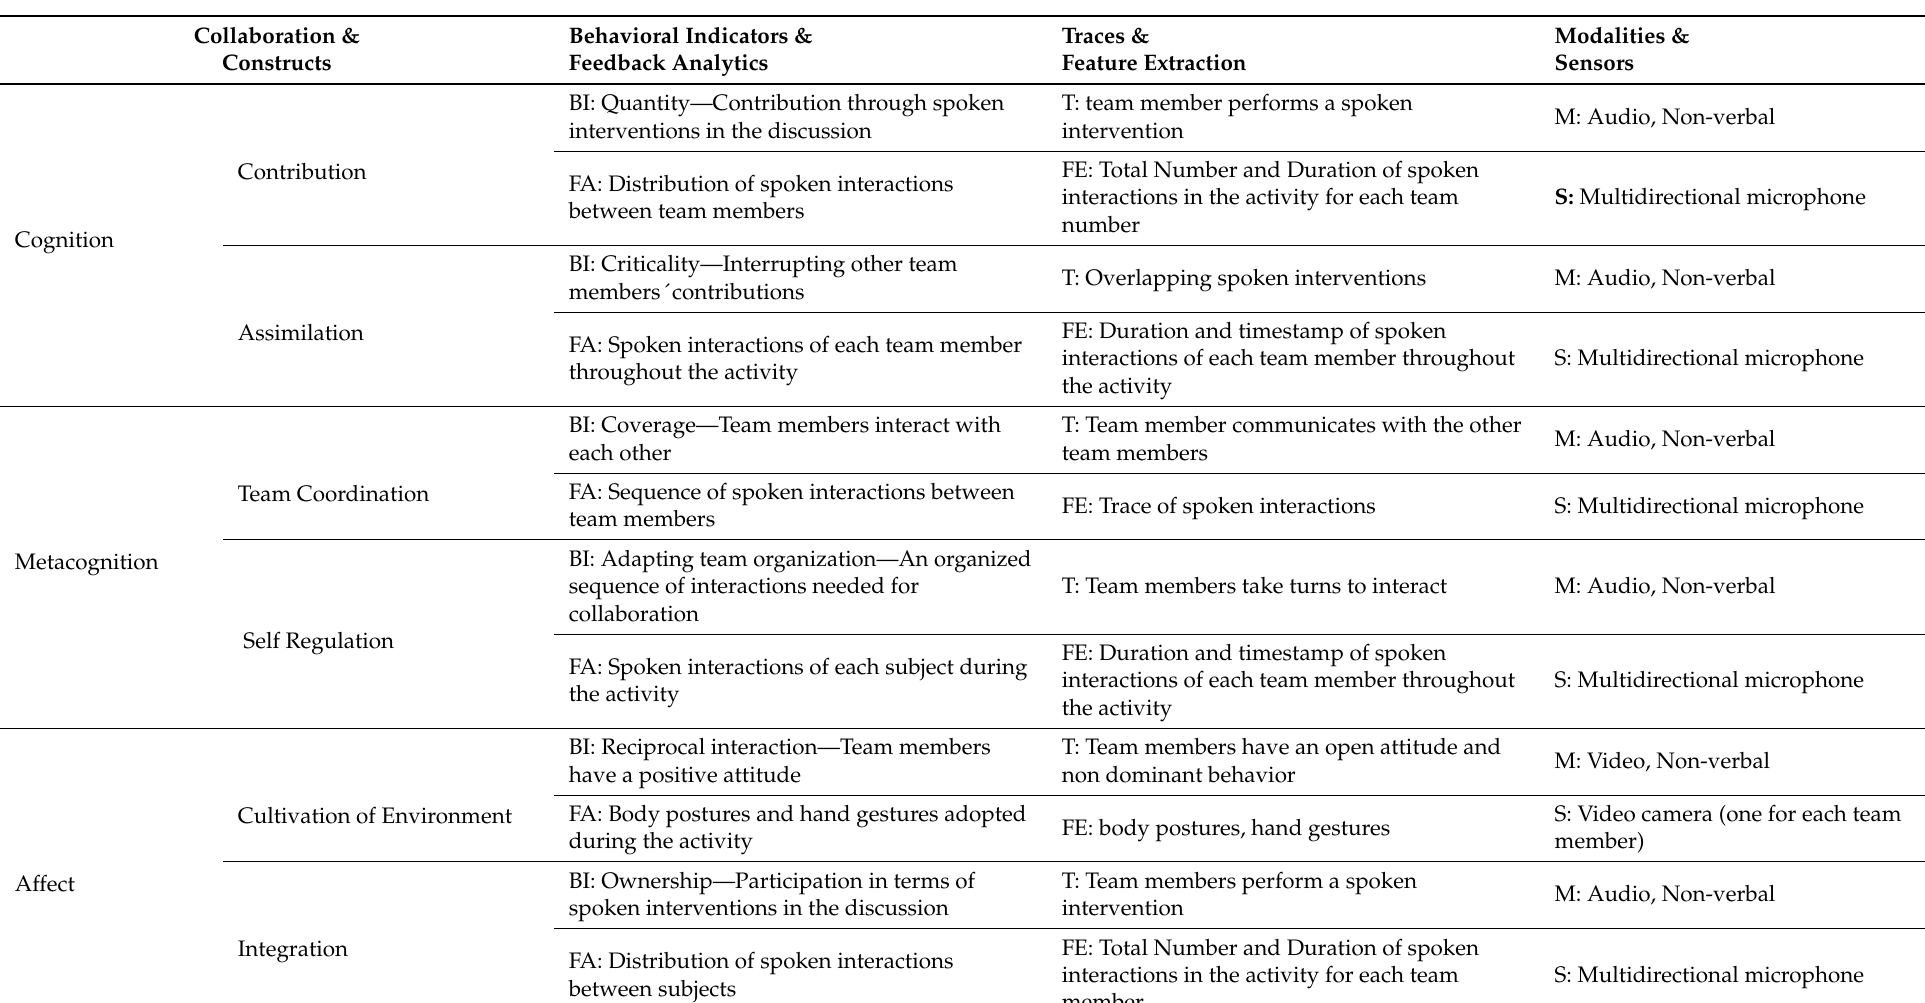
Table 2. Framework based on [21] for using MMLA in collaborative environments. Behavioral indicator (BI), Feedback Analytics (FA), Traces (T), Feature extraction (FE), Modalities (M), Sensors